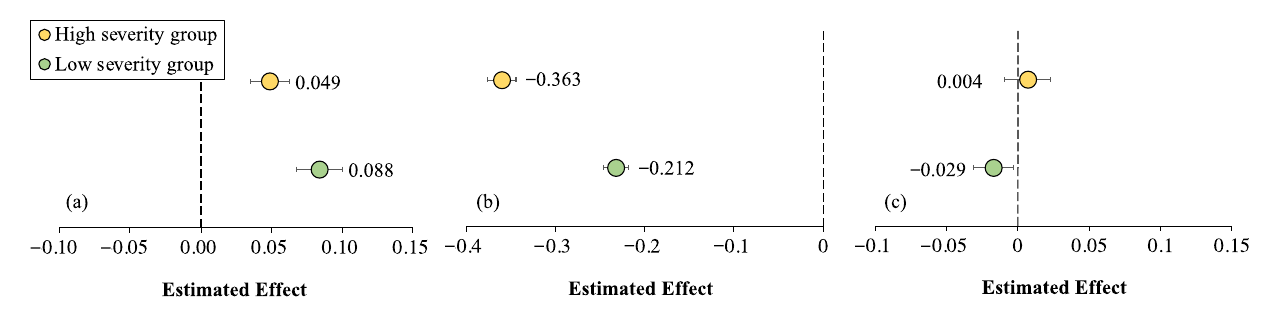
Figure 3. The effect of ( a ) COVID-19 symptom experience and ( b ) perceived life satisfaction on psy- chological distress and ( c ) the effect of COVID-19 symptom experience on perceived life satisfaction.